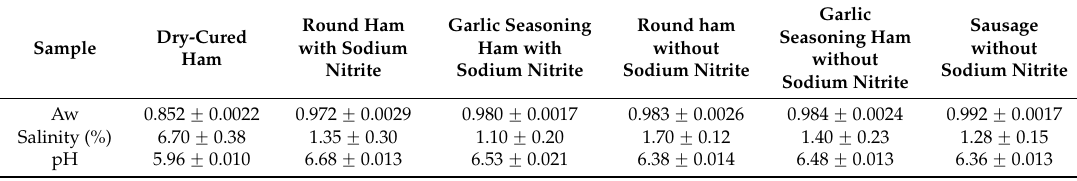
Table 2. The water activity (Aw), salinity and pH values of processed meat products.